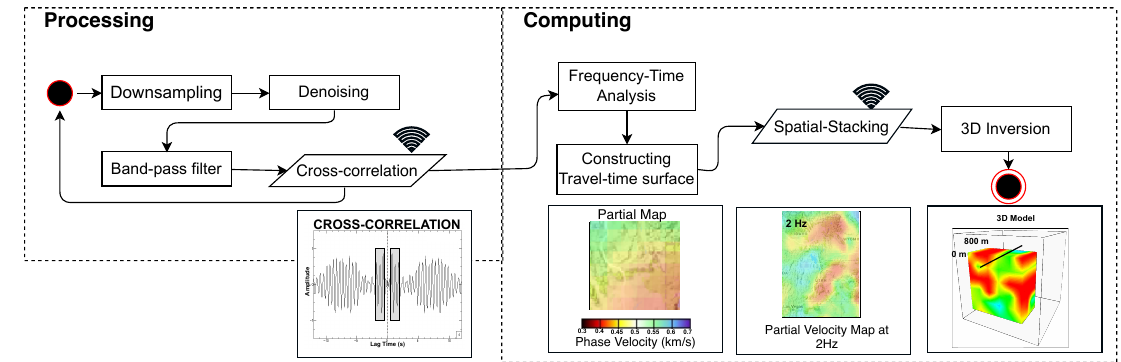
Figure 7. Processing and computing algorithm flows of ambient noise seismic imaging. The wireless sign in the figure means communication between nodes is